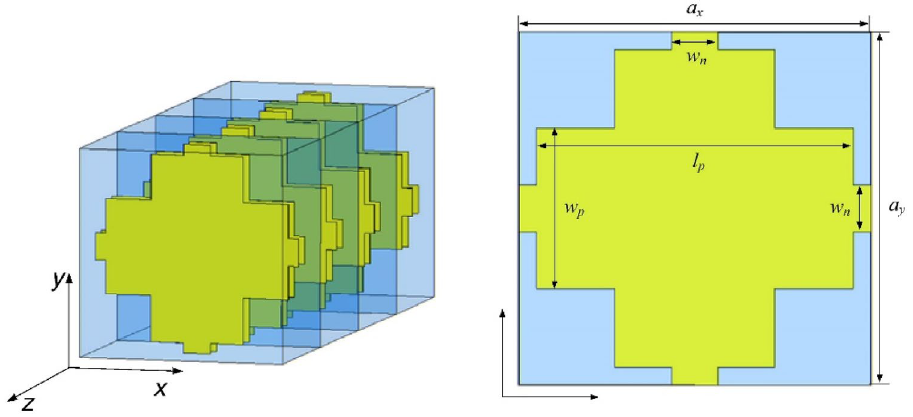
Figure 5. Du et al.’s three-dimensional fishnet metamaterial. Dimensions of the unit cell are a x = a y = 90 μm,